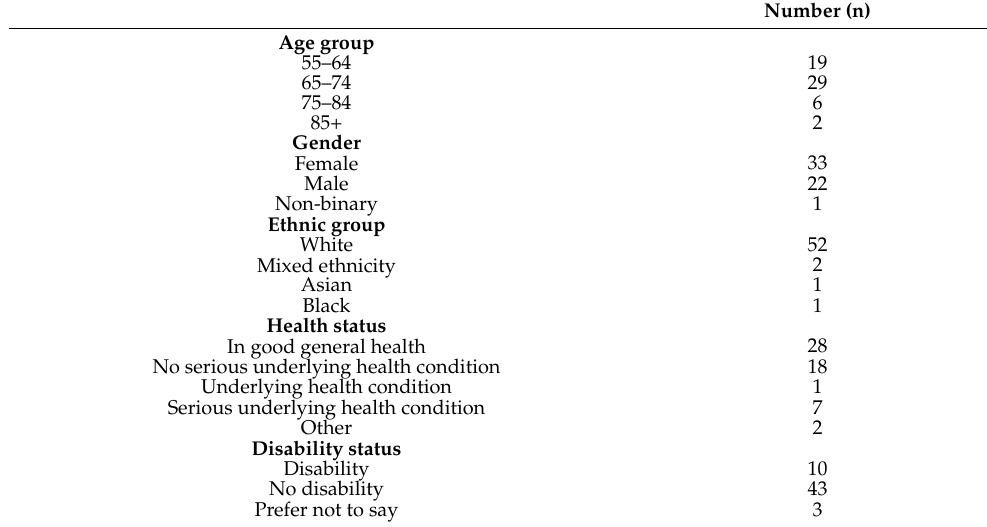
Table 2. Participant characteristics.